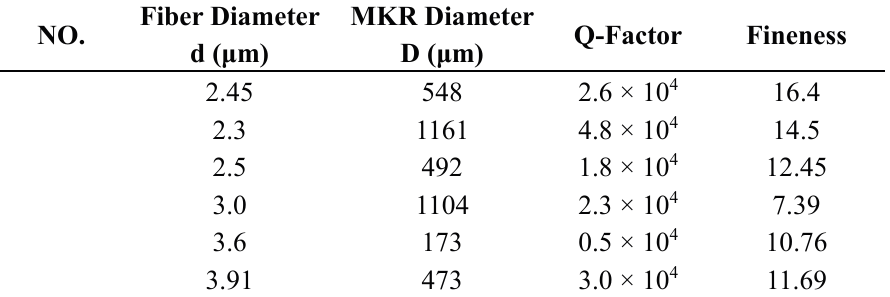
Table 1. The Q factor and fineness of MKRs under the same wavelength of 1550